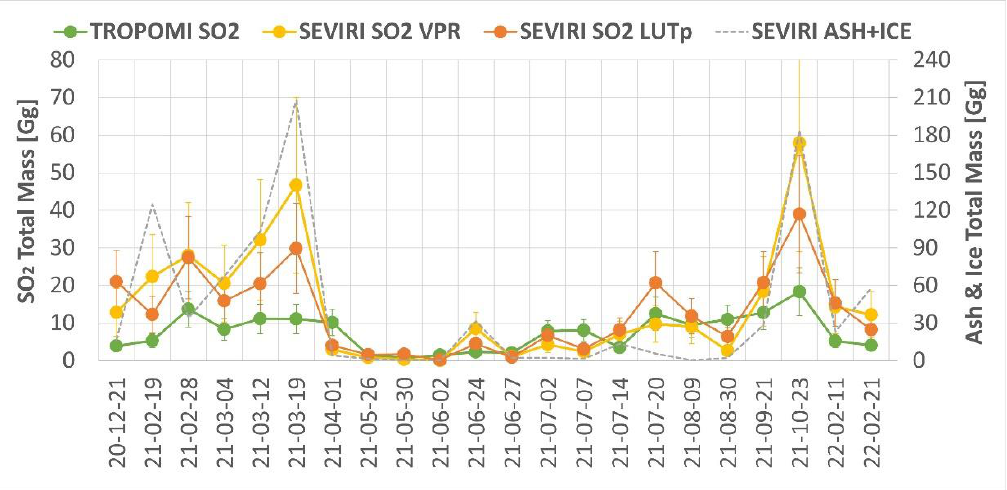
Figure 13. SO 2 total masses from SEVIRI-VPR, SEVIRI-LUT p , and TROPOMI. The error bars represent the retrieval uncertainties of the three procedures. On the secondary axis (right), the sum of VPR ash and ice total mass is reported also as a reference. The “Date” labels ( x -axis) are in the format year-month-day.